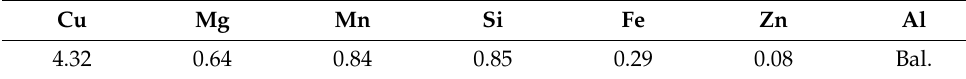
Figure 1. Tensile specimen size. Table 1. Chemical composition of 2A14 aluminum alloy